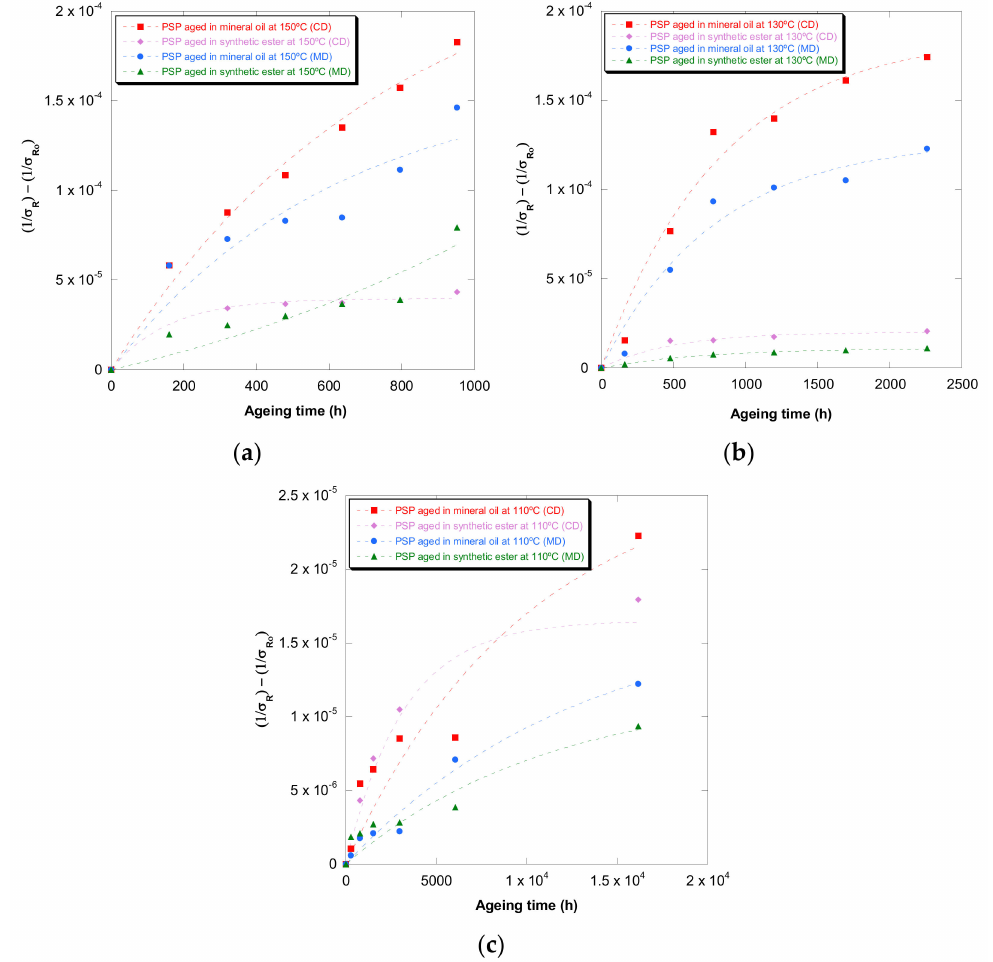
Figure 7. Evolution of the (1/ ε cm − 1/ ε cm0 ) in MD and CD as a function of temperature for pressboard PSP 3055 aged in mineral oil and in synthetic ester at 150 ◦ C ( a ), 130 ◦ C ( b ), and 110 ◦ C ( c ) and Emsley’s function.